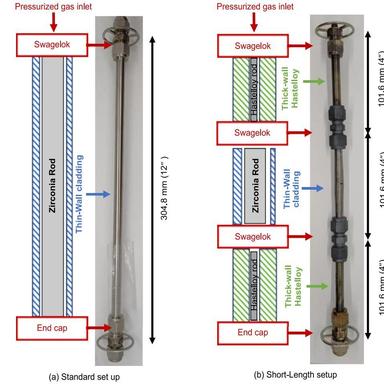
Illustration of (a) the standard and (b) the shortest-length specimens and their setup in the SATS. All samples, except the standard one, were assembled as shown in (b).